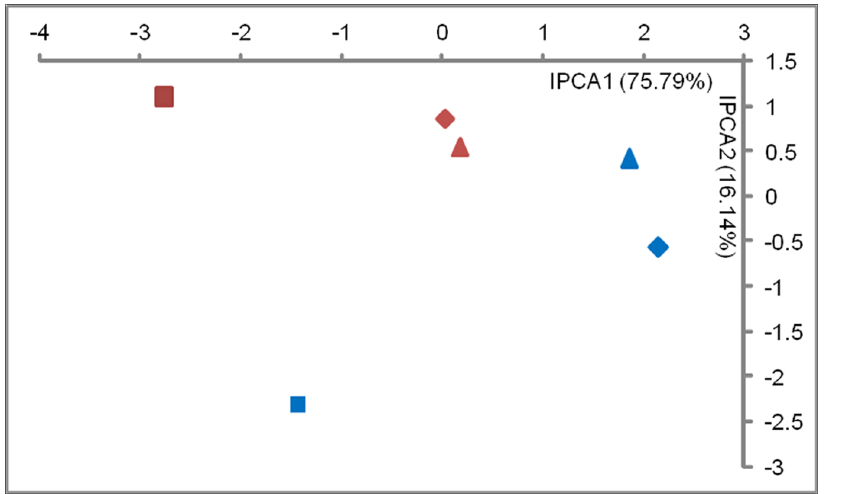
Figure 1. Effect of Bacillusamyloliquefaciens FZB42-Rif application and Rhizoctoniasolani AG1-IB inoculation on the rhizosphere bacterial community in pot experiments. Ordination plot of bacterial community T-RFLP data analyzed with AMMI. Symbols m represent plants treated with FZB42-Rif; ¤ uninoculated controls; & plants grown in presence of R. solani ( + Rs ) Red: Sampling after 2 weeks of growth; Blue: Sampling after 4 weeks of